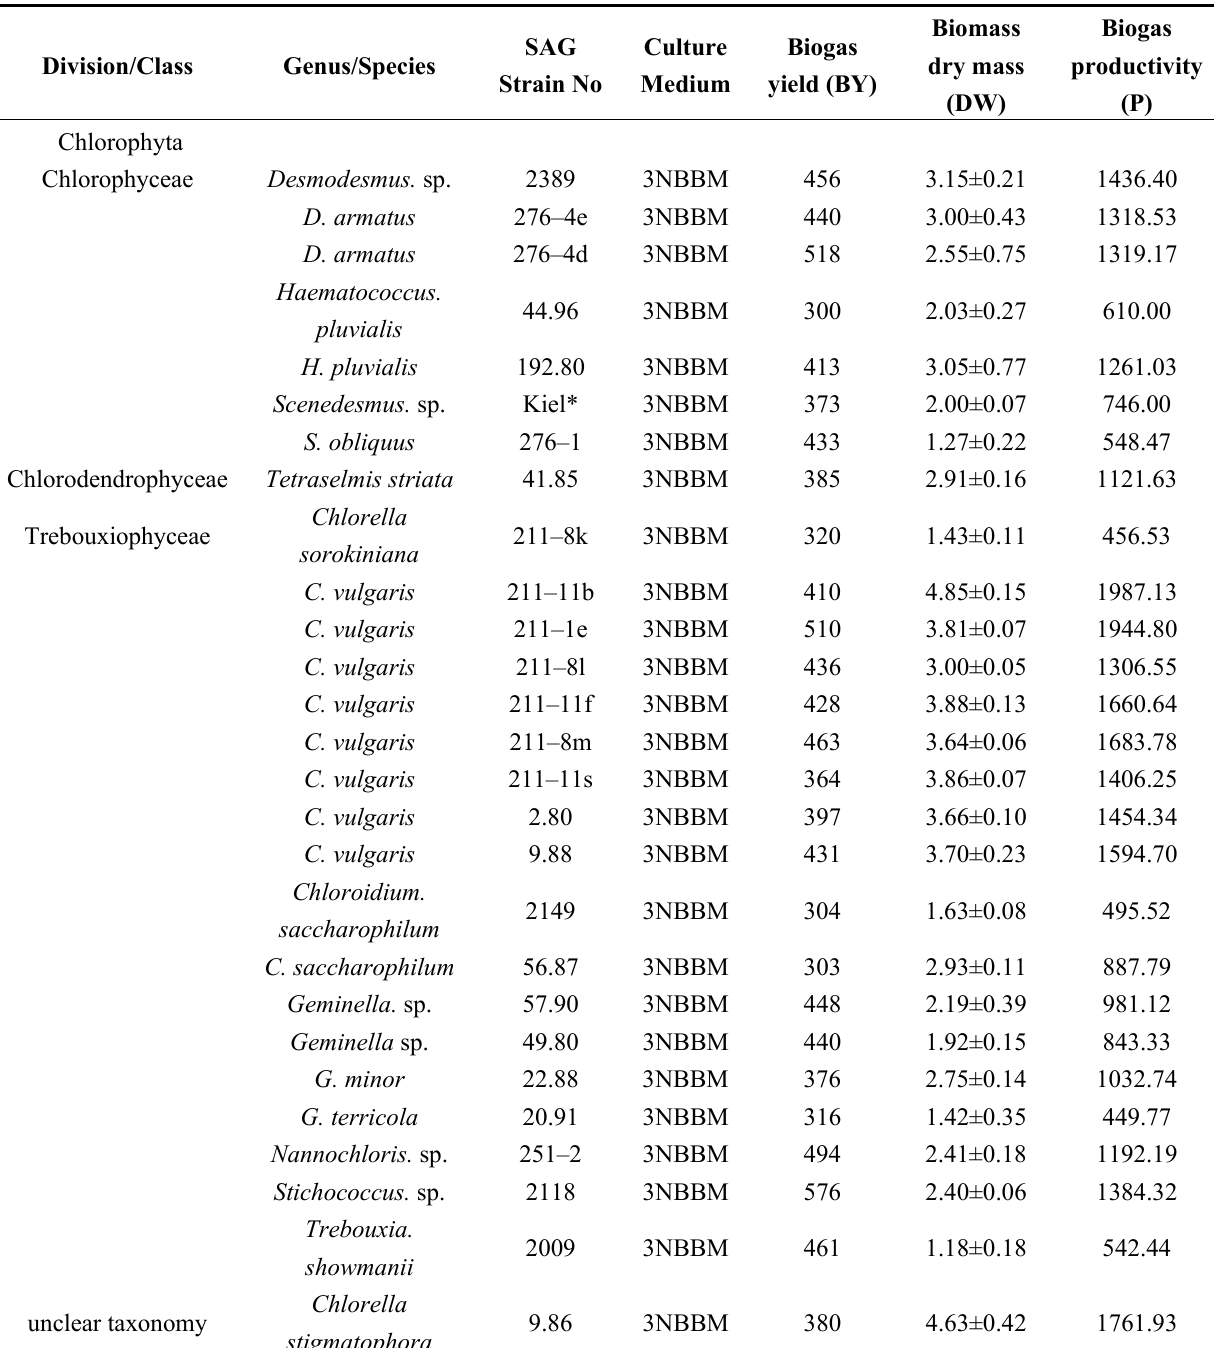
Table 1. Biogas yield (BY) (mL/g ODM), biomass production (DW) (g/l DW) and biogas productivity (P) (mL/l culture volume) of microalgae and cyanobacteria strains. Maize starch was used as a positive control. Sewage sludge without substrate addition was used as a reference and was